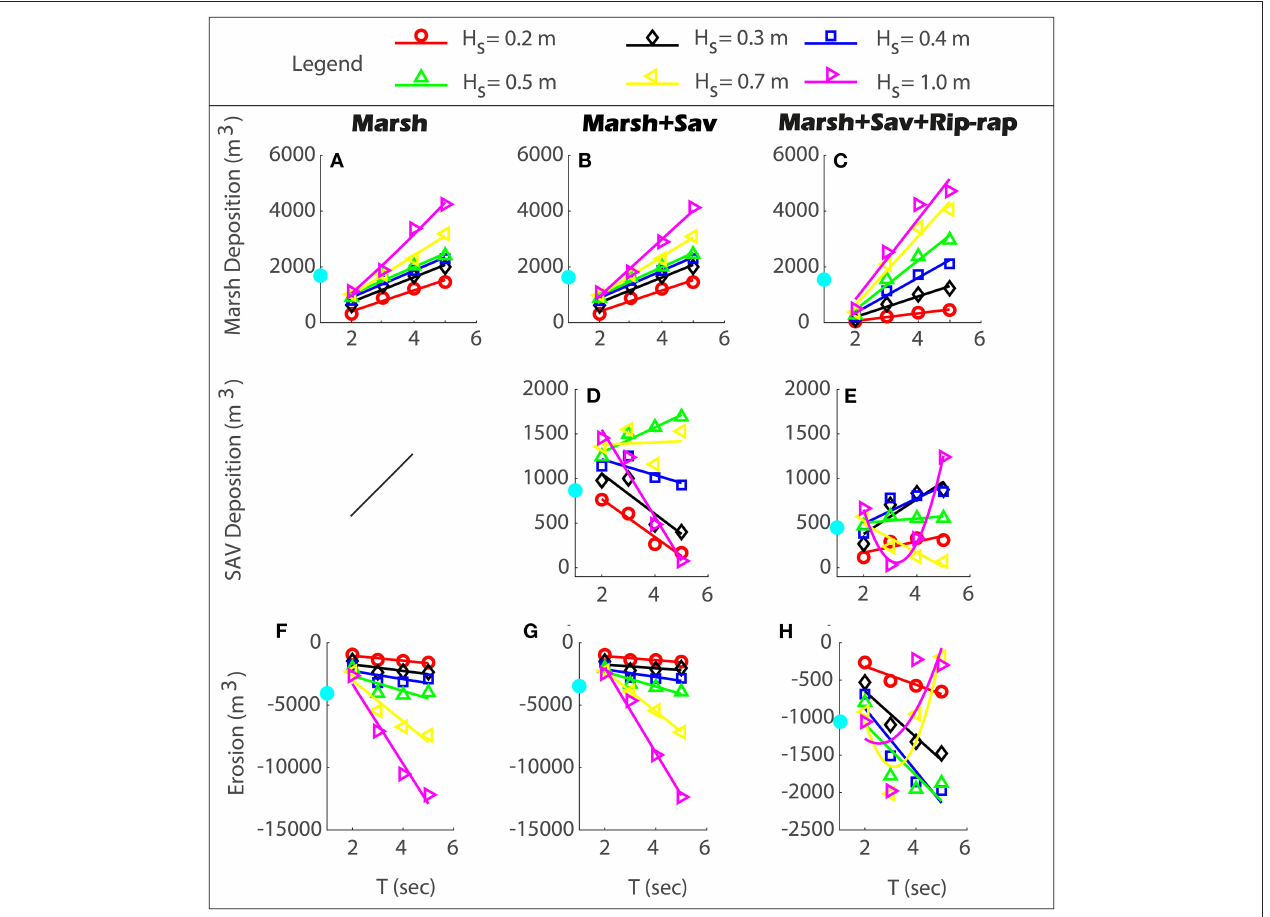
FIGURE 8 | Summary of marsh and SAV deposition, and erosion for the different simulated scenarios with slope (B,D,G) refers to the case with marsh and SAV. (C,E,H) refer to the case with both vegetation communities and the rip-rap. The light blue dot on the y-axis denotes the mean